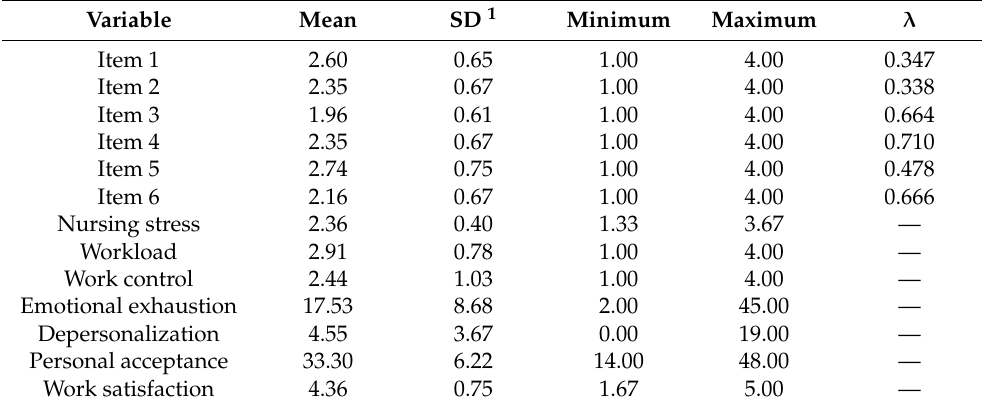
Table 2. Descriptive statistics for the Brief Nursing Stress Scale (BNSS) items, total score, indicators of workload and work control, dimensions of burnout, and work